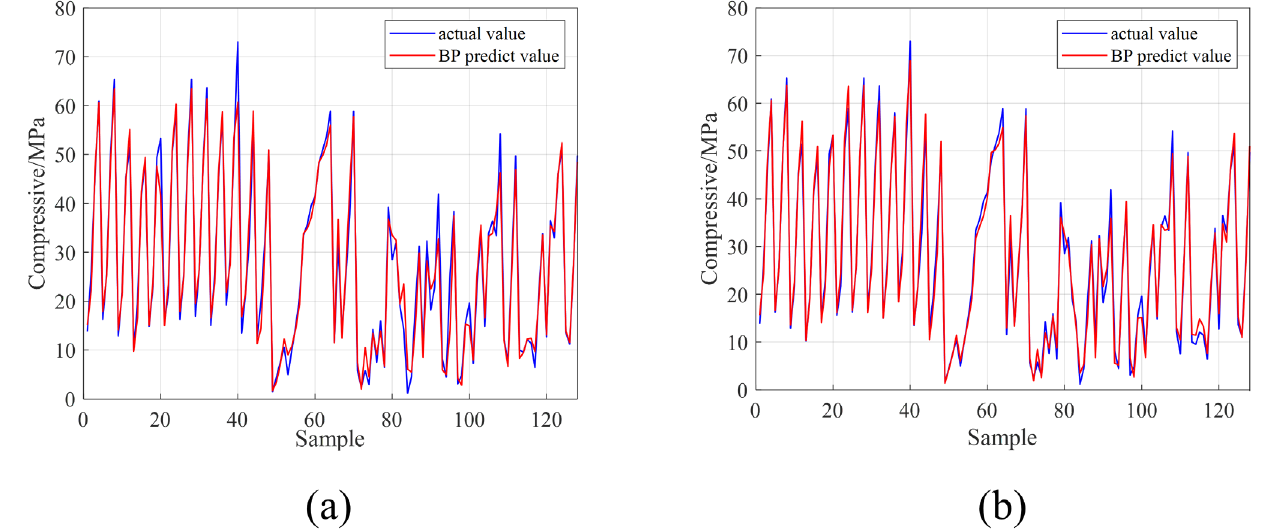
Figure 10. The actual value and the predict value of the training sets ( a ) the P-BR and ( b ) the AO-BR. Table 10. Evaluation metrics for training set of the P-BR and the